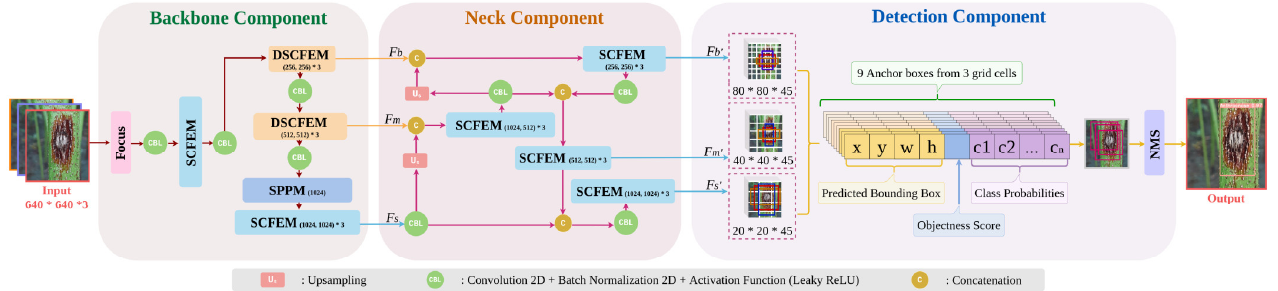
Figure 3. The overall architecture of YOLO-JD. The architecture contains three components—the head (backbone) component, the neck component, and the detection component. Structures of the three new modules: SPPM, SCFEM, and DSCFEM are detailed in Figure 4.